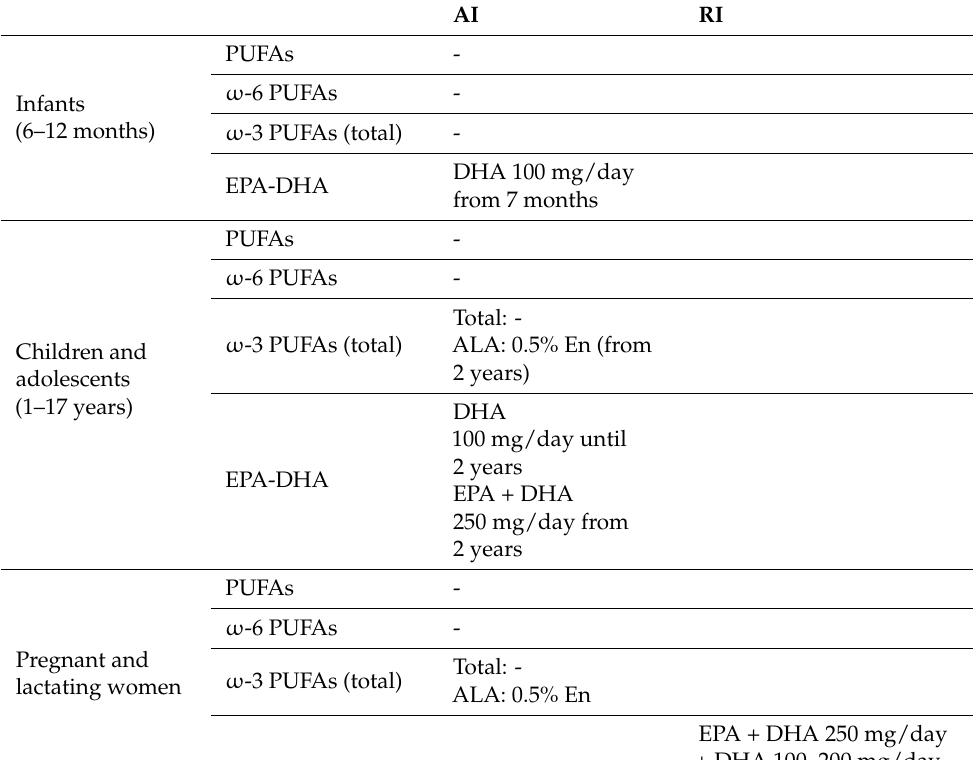
Table 2. Recommended polyunsaturated fatty acids (PUFAs) daily dose. AI